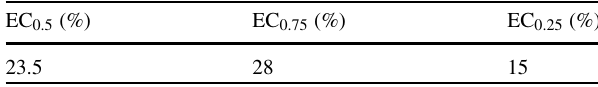
Table 9 EC quantiles for median estimation